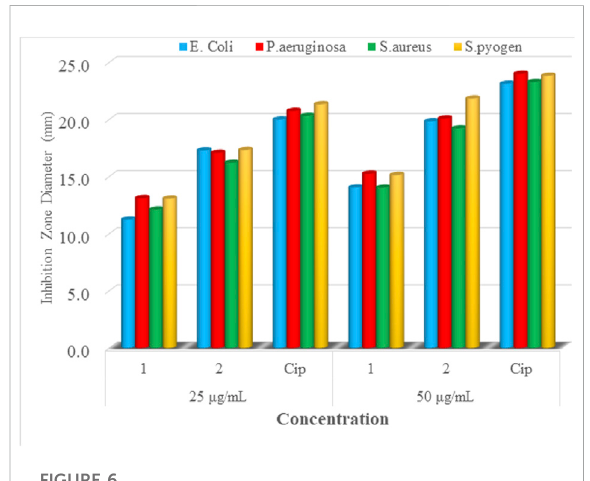
FIGURE 6 Mean inhibition zone diameter of mixed-drug metal complexes 1 and 2 and cipro fl oxacin in mm at 25 and 50 µg/ml.